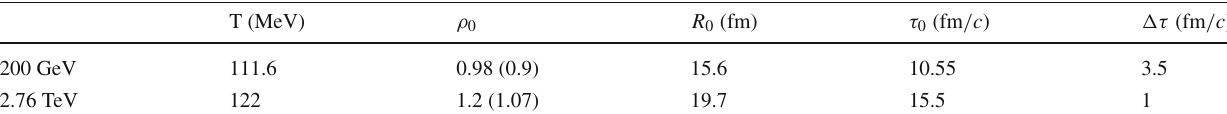
Table 5 The blast-wave model parameters for proton ( (cid:3) ) in Au + Au collisions at [67,68] as well as in Pb+Pb collisions at